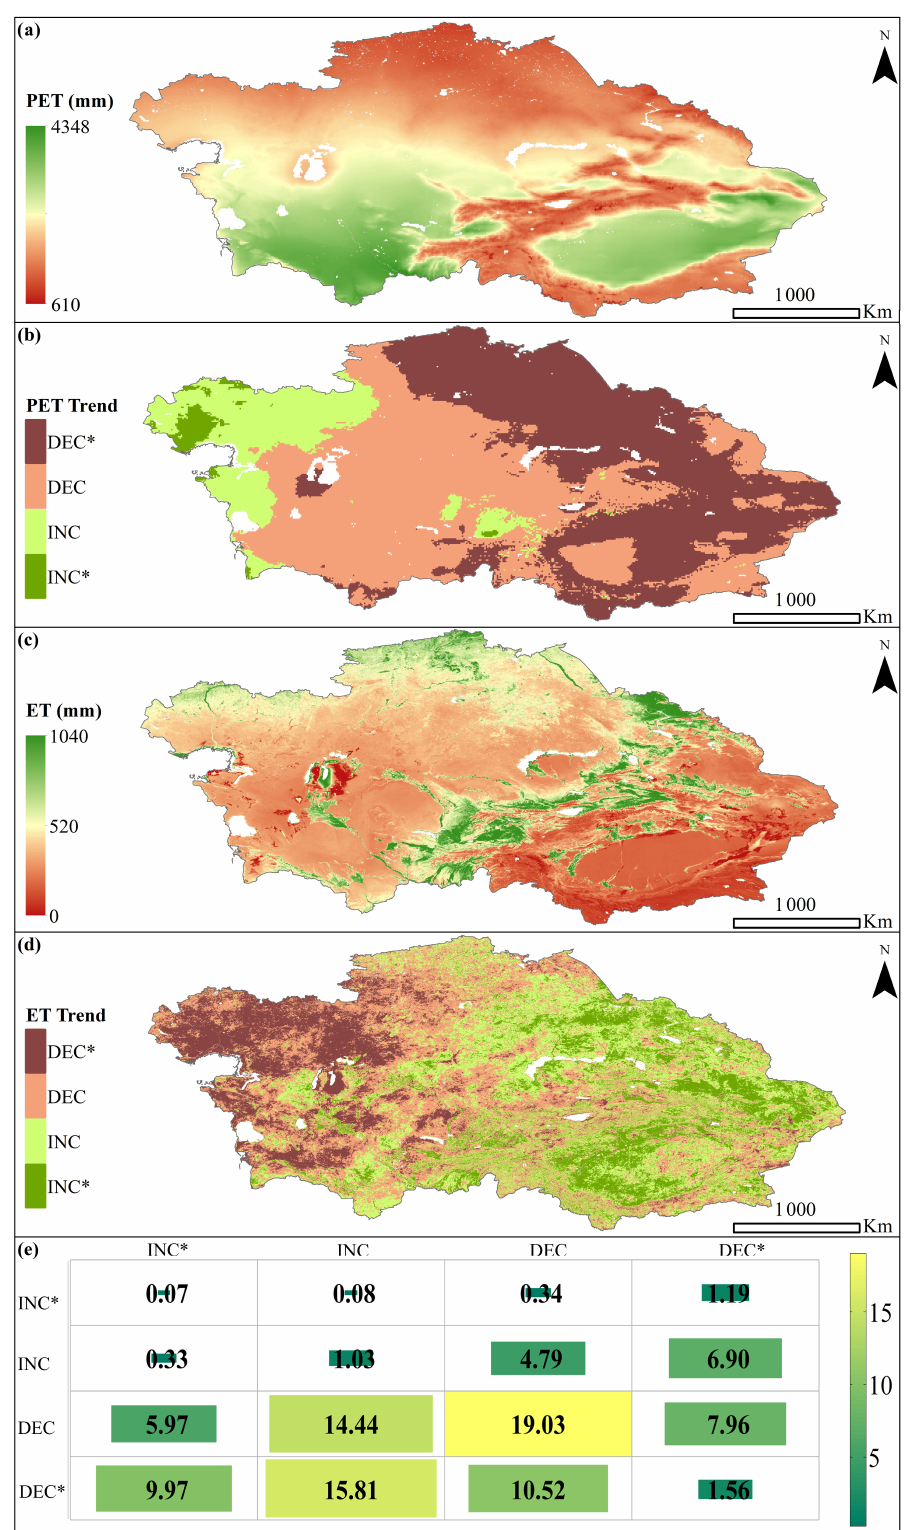
Figure 2. Spatiotemporal changing trends of annual PET and ET during 2000–2020. ( a , b ) Multi-year average PET and its changing trend over the same period. ( c , d ) Multi-year average ET and its changing trend during the same period. ( e ) Area transfer matrix between PET and ET , with different change trends. The characters “DEC” and “INC” mean the decrease and increase trends, respectively, and the symbol “*” shows that the change trend reaches the significant level (95%